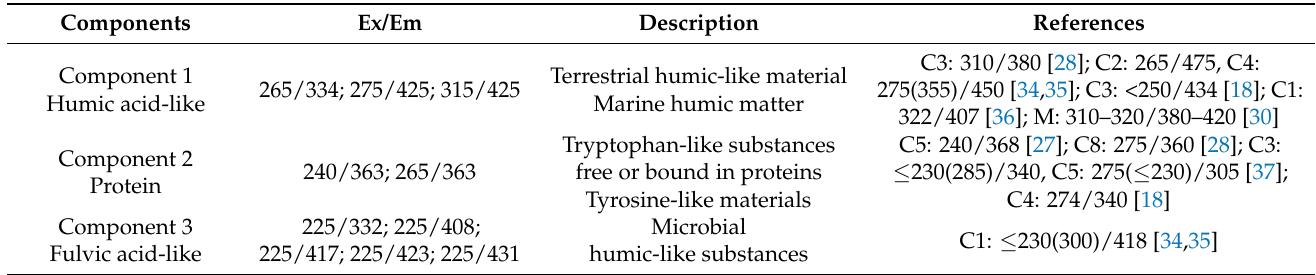
Table 2. Characteristics of the three fluorescence components from the water regimes of the Qilian- shan